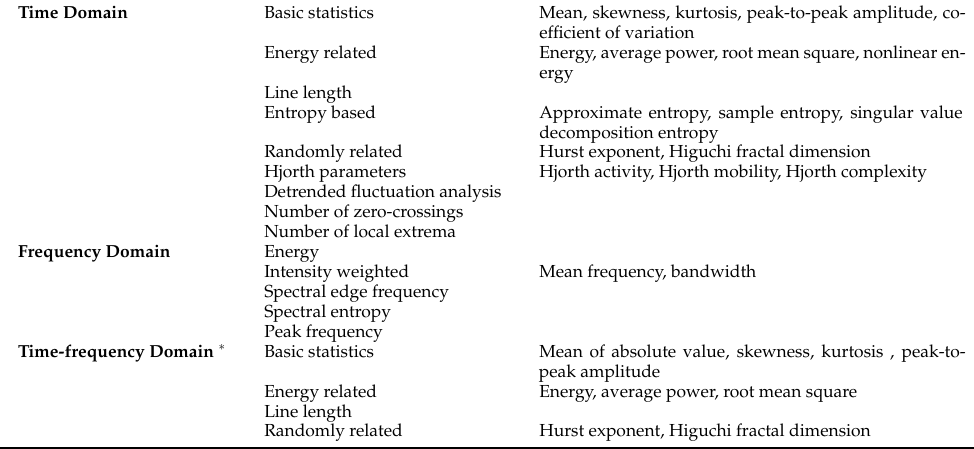
Table 2. The list of the features extracted from time, frequency, and time–frequency